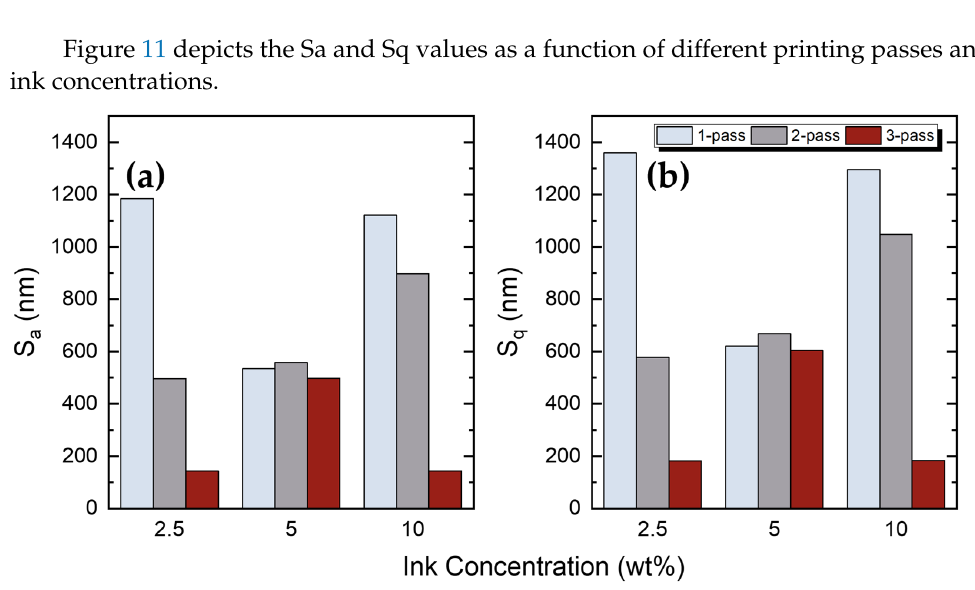
Figure 11. ( a ) Arithmetic mean height (Sa) between the roughness profile and the mean line; ( b ) root mean square of the surface roughness (Sq) as a function of different printing passes and ink concentrations.